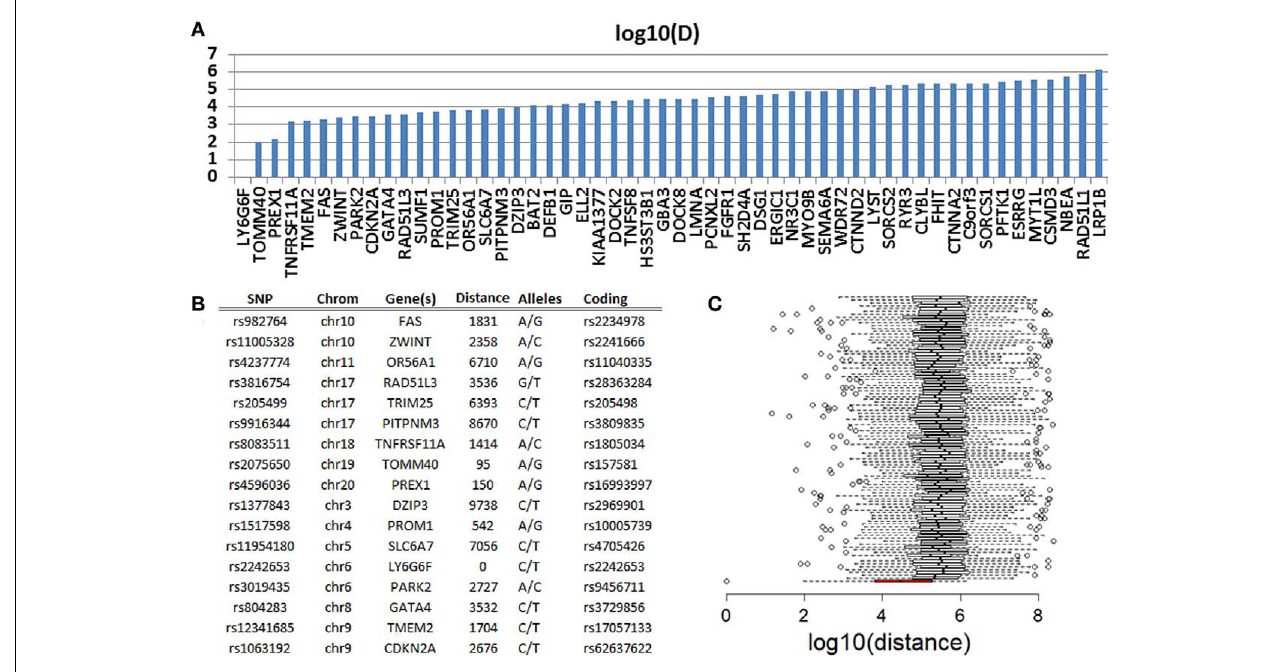
The 100 box plots in white show the distributions of the distance between SNPs chosen at random from the SNPs included in the genome-wide association study in Sebastiani et al. (2012) and the closest coding SNPs in PG17 and PG26.Wiskhers extend to 1.5 SD from the quartiles and circles represent